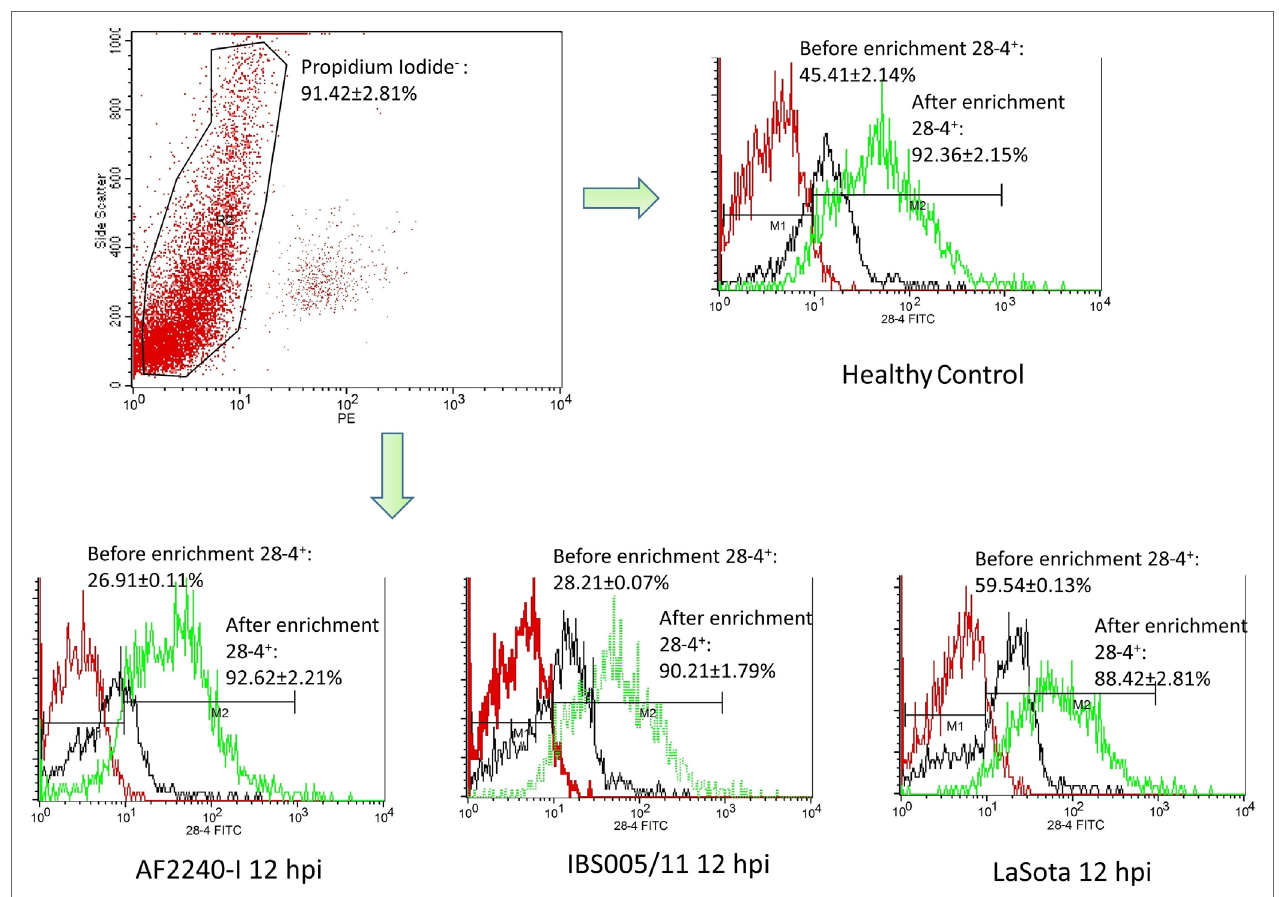
TaBle 3 | Percentage of 28-4 + cells in total IEL-NK cells obtained from chickens infected with different Newcastle disease virus (NDV) strains. nDV strain 28-4 + iel-nK cells 12 hpi 36 hpi 72 hpi AF2240-I 26.91 ± 0.11 a,1 * 25.90 ± 0.55 b,3 * 5.66 ± 0.24 a,b,4 * IBS005/11 28.21 ± 0.07 c,2 * 23.71 ± 0.16 c,3 * 10.18 ± 0.13 c,4 * LaSota 59.54 ± 0.13 d,1,2 * 57.47 ± 0.11 d,3 * 41.22 ± 0.92 d,4 * For uninfected control, the percentage for 28-4 + cells was 45.41 ± 2.14. Values with asterisk compared to control differ significantly. Values with same letters differ significant between different NDV strains. Values with same number differ significant between different time points by using two-way ANOVA (p ≤ 0.05). The value was the means ± SEM of three experiments. Values with same letter differ significantly between different NDV strains. Values with same number differ significantly between different time